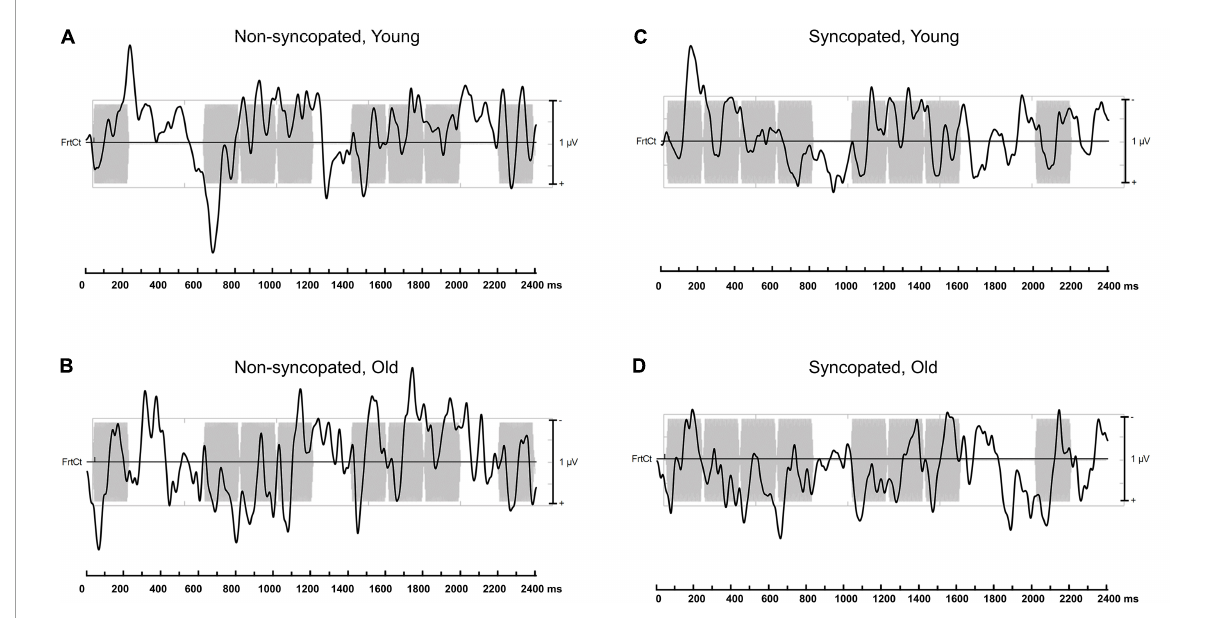
FIGURE5 Electroencephalography (EEG) data presented in the time-frequency domain averaged across each repetition of the rhythm and the montage of fronto-central electrodes used in analysis for younger adults (A,C) and older adults (B,D) for non-syncopated (A,B) and syncopated (C,D) rhythms for slow tempo overlaid onto their respective auditory stimuli.